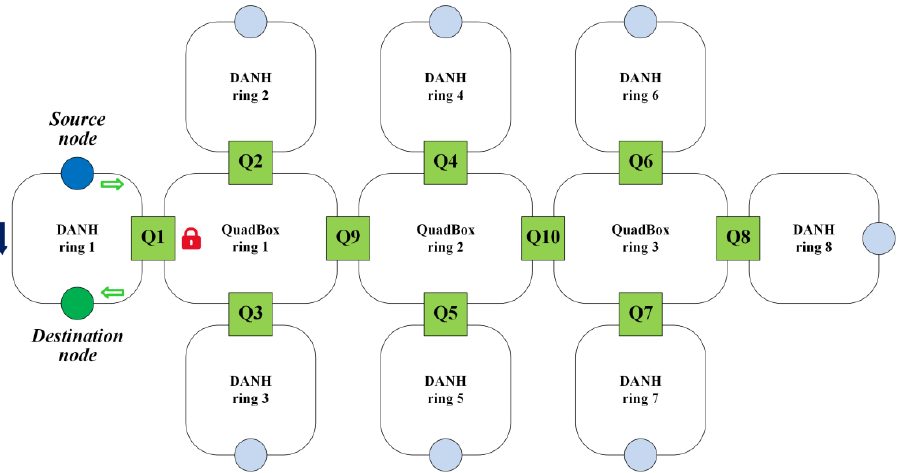
Figure 15. Network traffic under the FHT approach in Case